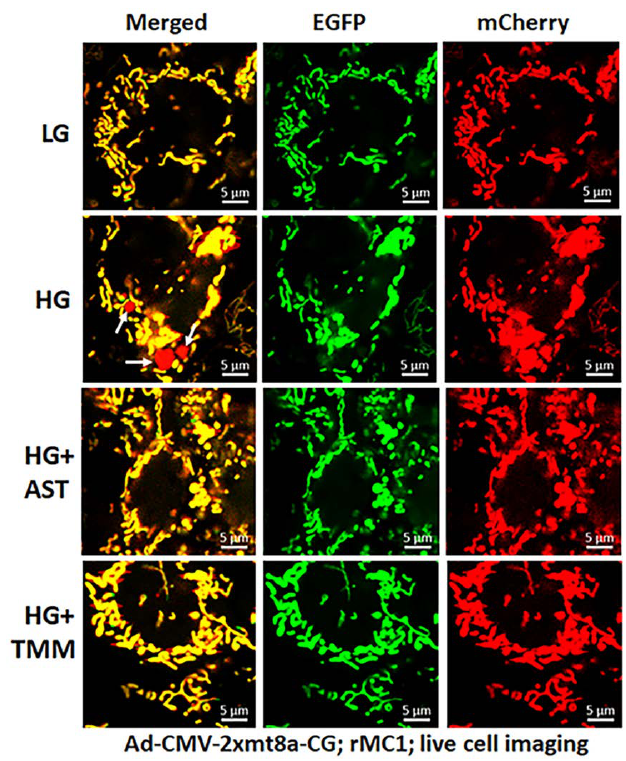
Figure 7. Combination triple drug treatment reduces mitophagy in rMC1 under HG in live-cell imaging. rMC1 cells were transduced with 2 × mt8a-CG (mCherry-EGFP) for 3 days under HG or LG. When drug treatments were performed, they were present for 24 h before the confocal live-cell imag- ing. We observed that HG increases red mitolysosome formation (white arrows, HG second panel) when compared to LG. Active mitochondria show yellow (red and green), while damaged mitochon- dria after flux to lysosomes yield red due to EGFP (green) quenching. Interestingly, combination triple drug treatment with AST (amlexanox, SS-31 and tranilast) or with TMM (TXNIP-IN1+Mito- Tempo+ML-SA1) reduces mitophagic flux in rMC1 under HG (last two panels, respectively). A representative of n = 3 is shown here, captured at 630 × magnification in a Zeiss confocal